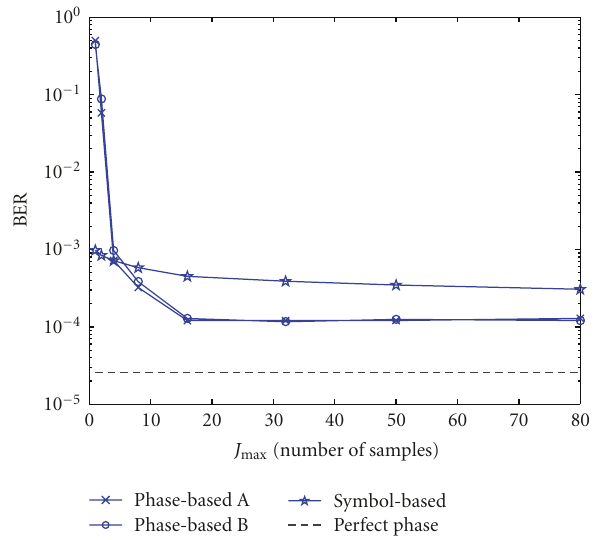
Figure 3: BER performance for coded setup ( σ 2 pilots).